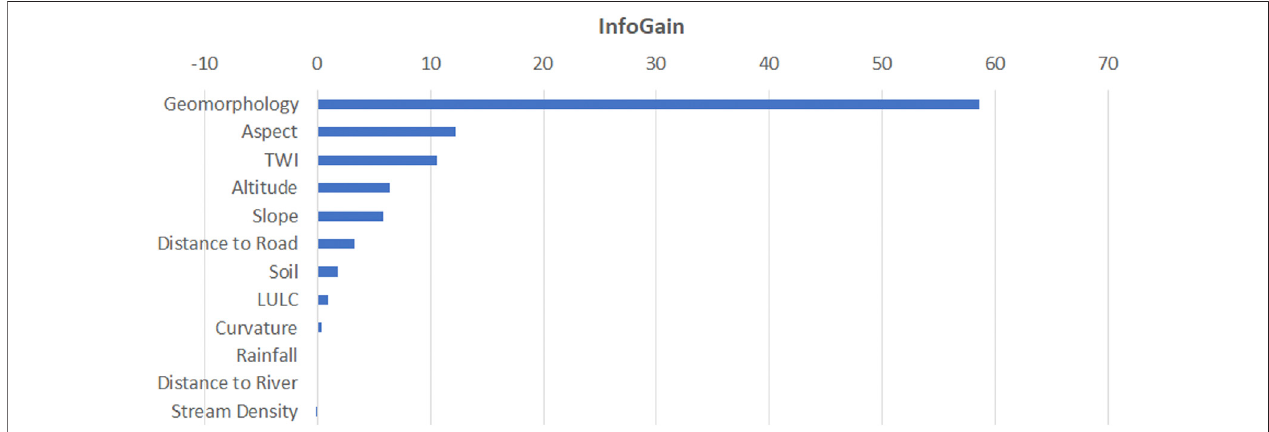
FIGURE 4 | Importance of fl ood predictors derived through the use of IG arranged in order of their contribution to fl ood occurrence prediction.